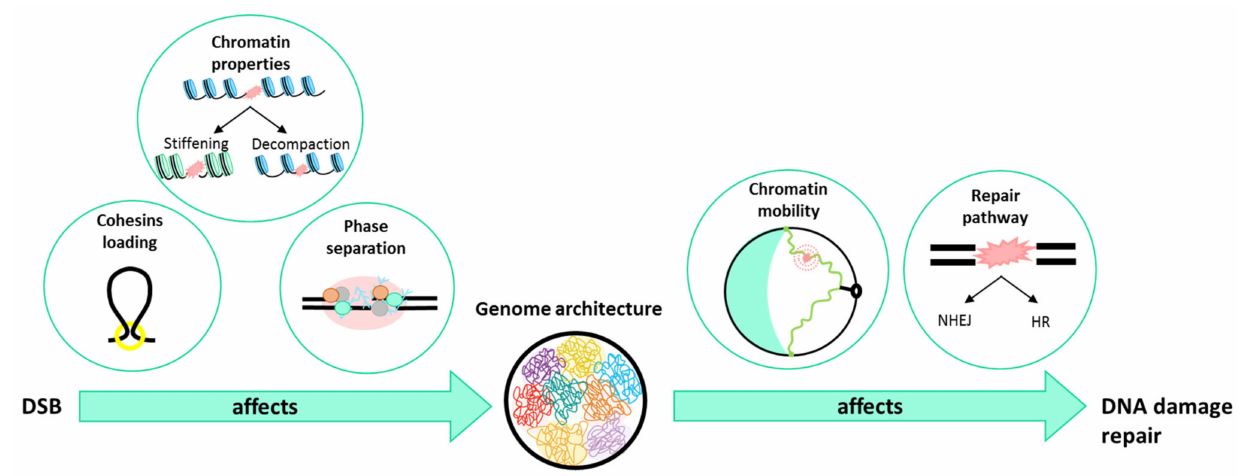
Figure 3. Relationship between DSB, genome architecture, and repair. After a DSB, different factors are involved. One of them is the loading of cohesins that confine repair factors by favoring cis contacts in mammals and yeast. A second factor concerns the changes in chromatin properties such as stiffening and/or decompaction. Finally, the recruitment of repair factors allows the formation of liquid droplets around the damaged locus. On the other hand, genome architecture affects DNA damage repair by increasing chromatin mobility upon damage differently, depending on the DSB position in yeast, and by influencing the choice of the repair pathway, depending on the damaged